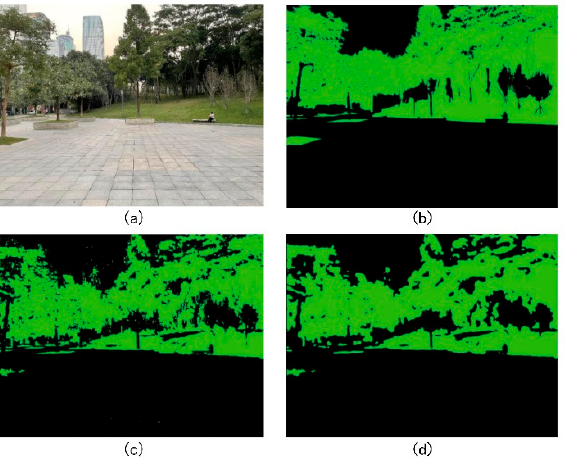
Figure 4. Process and effect of green pixel algorithm extraction: ( a ) original photo; ( b ) actual green in original image; ( c ) green part of original image is extracted; ( d ) optimized effect after denoising.